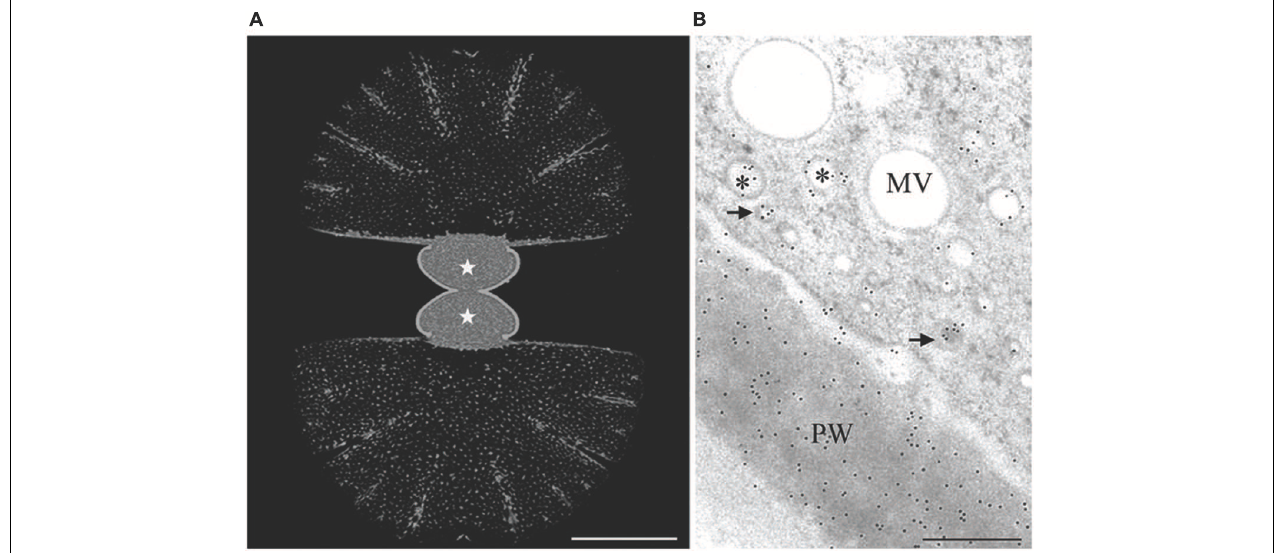
FIGURE 3 | Immuno labeling of growing Micrasterias cells by monoclonal anti-AGP antibody JIM13. (A) Labeling of the primary wall of both growing semicells (asterisks) visualized in CLSM. The non-growing secondary walls of the old semicells (upper and lower part are not labeled). Scale bar is 50 µ m. (B) TEM micrograph showing labeling of primary wall (PW) and two different vesicle populations indicated by asterisks and arrows (scale bar is 0.5 µ m). Reprinted with permission from Eder et al. (2008), Copyright © 2008 Phycological Society of America.